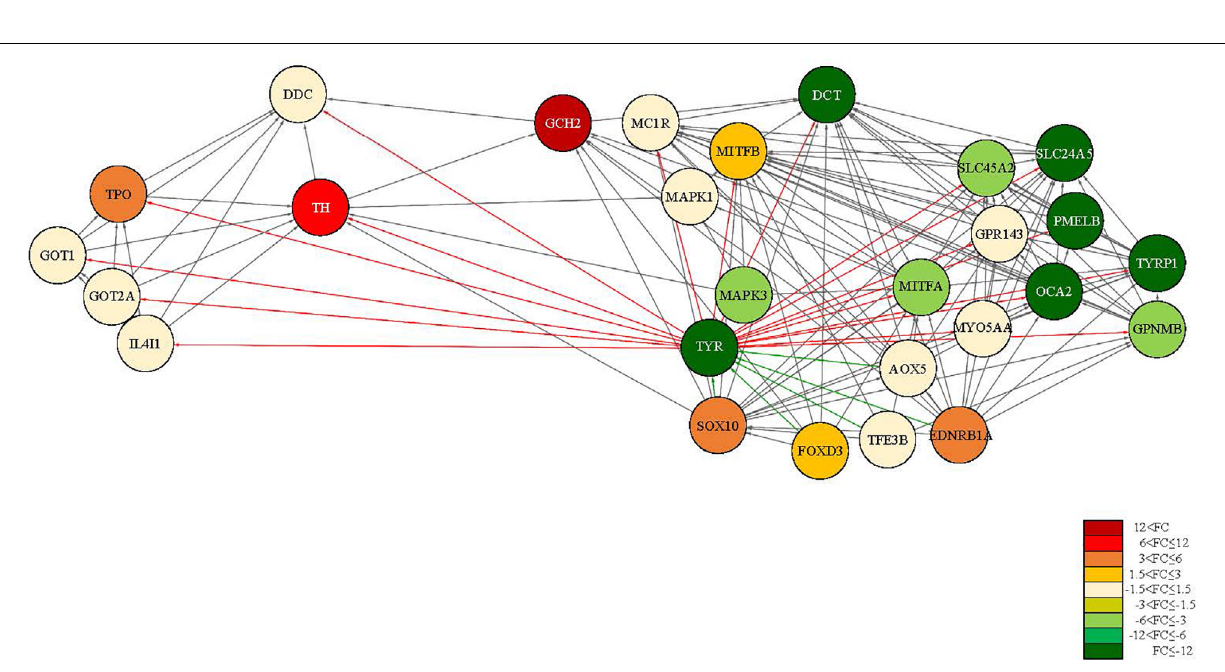
Frontiers in Marine Science |